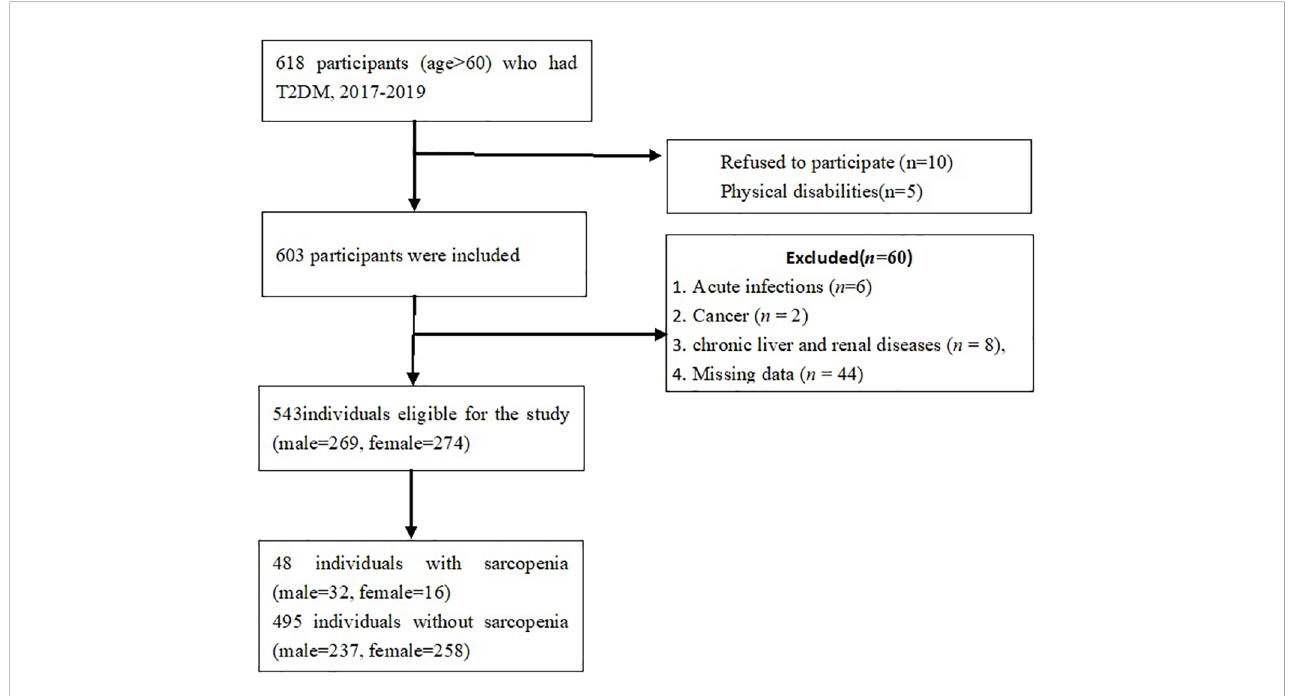
FIGURE 1 Flow chart on selection of